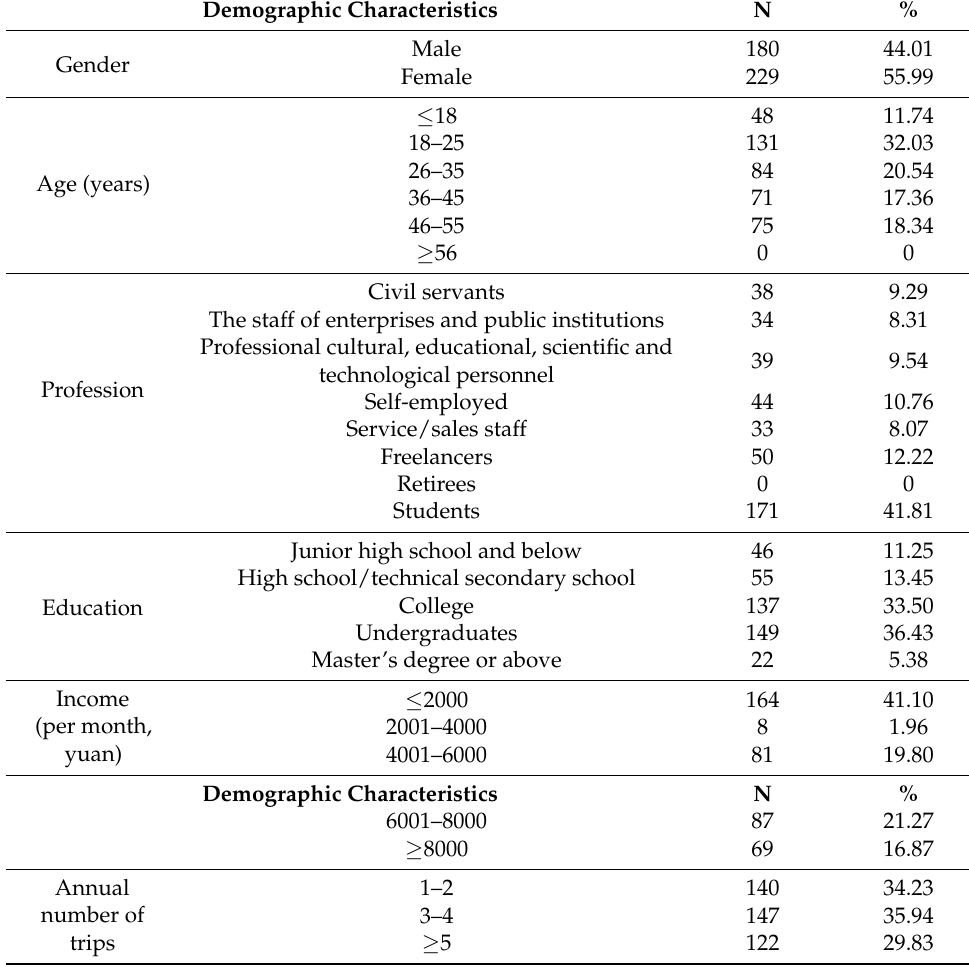
Table 4. Demographic profile of respondents.